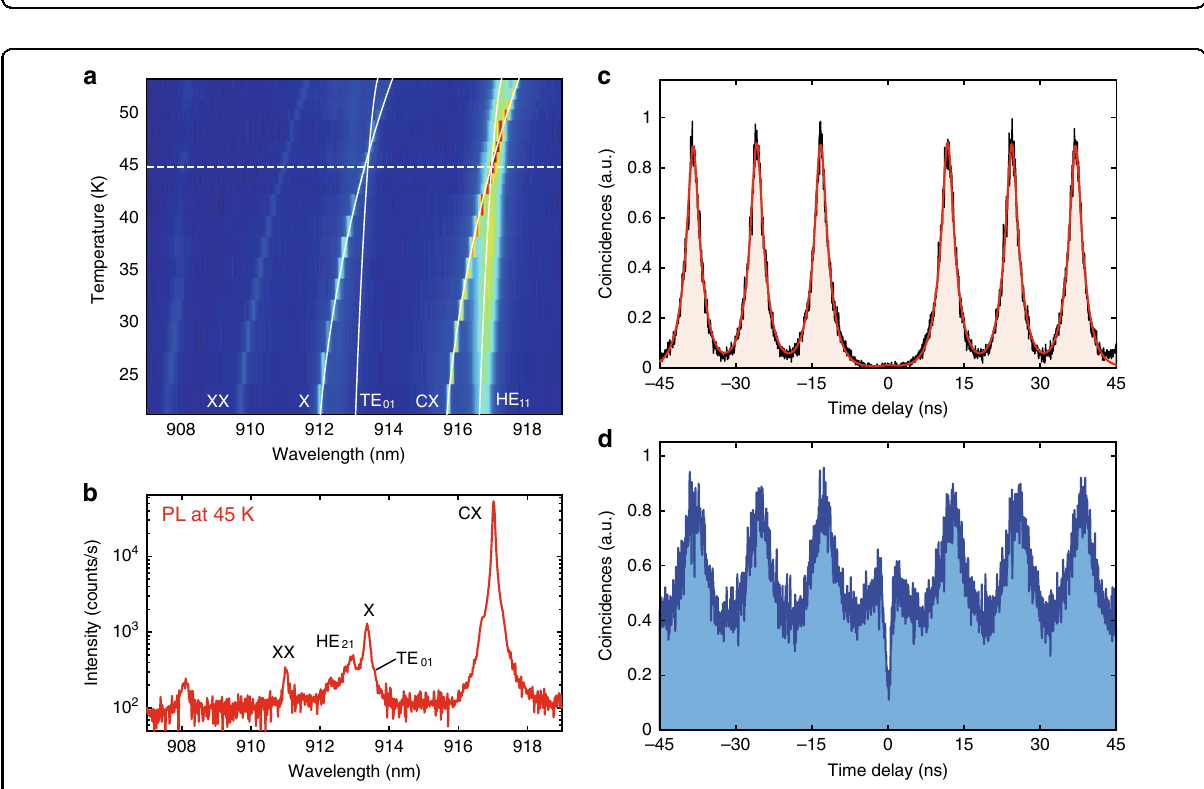
Fig. 3 Dual-resonance enhanced X-CX transition for the highly pure single-photon emission. a Temperature-dependent PL mapping of a QD coupled to a 2.5 μ m diameter micropillar cavity, the white line is guide for the eyes. b Log scaled line cut of PL mapping in ( a ) from a QD obtained under above-band (780 nm) excitation at temperature of 45 K. At this temperature, the CX is tuned into resonance of the HE 11 mode and X is resonant with TE 01 mode. c , d Hanbury Brown and Twiss (HBT) measurements of single-photon purity for the dual-resonance enhanced intra-dot excitation and the above-band excitation. Strong suppression of the carrier recapturing process is observed via intra-dot excitation, leading to a background-free g (2) (0) value as low as